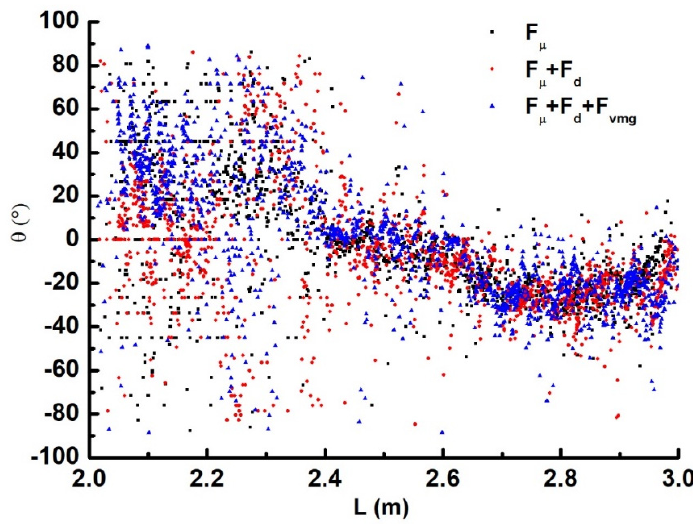
Figure 10. Particles velocity direction distribution in different initiation modes.